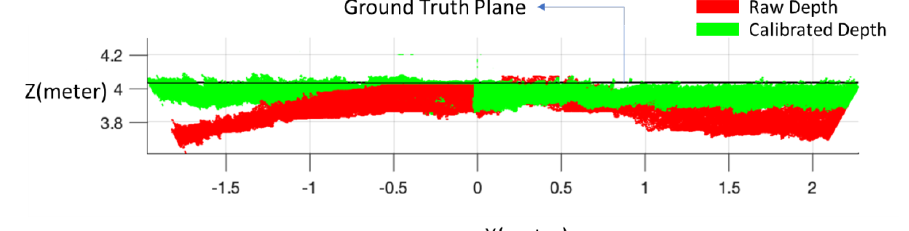
Figure 3. The comparison between the raw depth and calibrated depth.